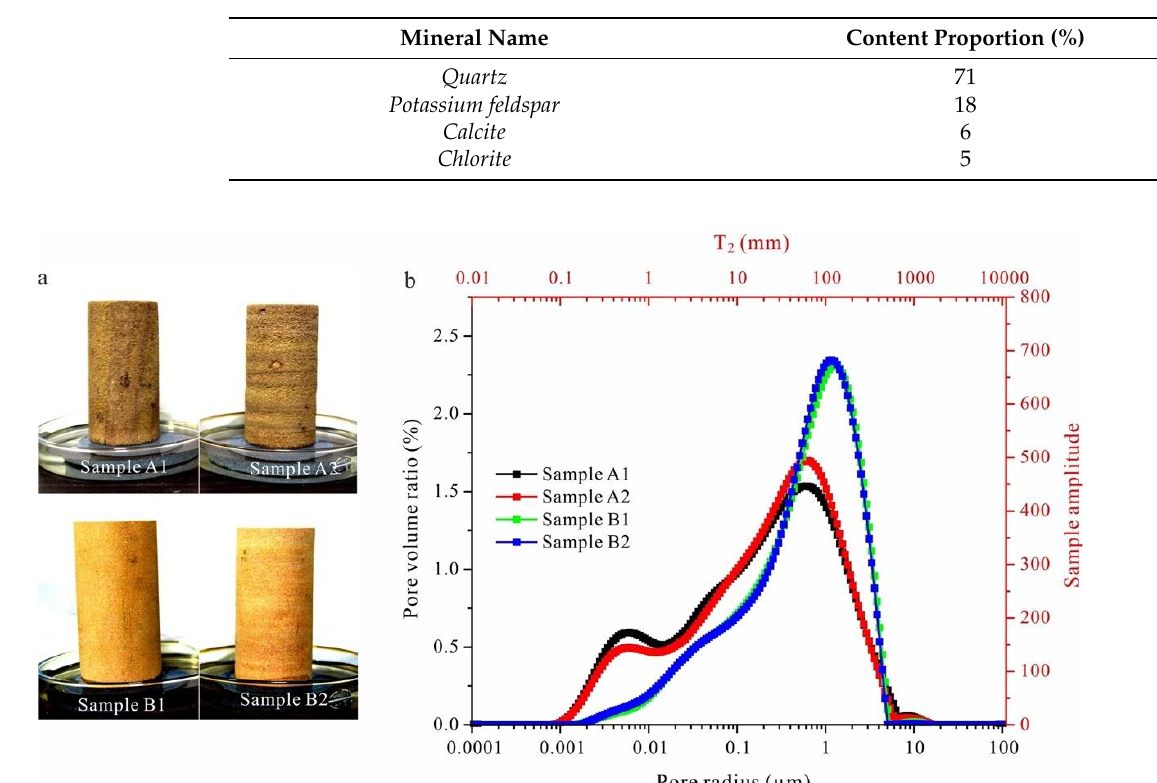
Figure 1. Test samples ( a ) and their pore size distributions and T 2 spectra ( b ).